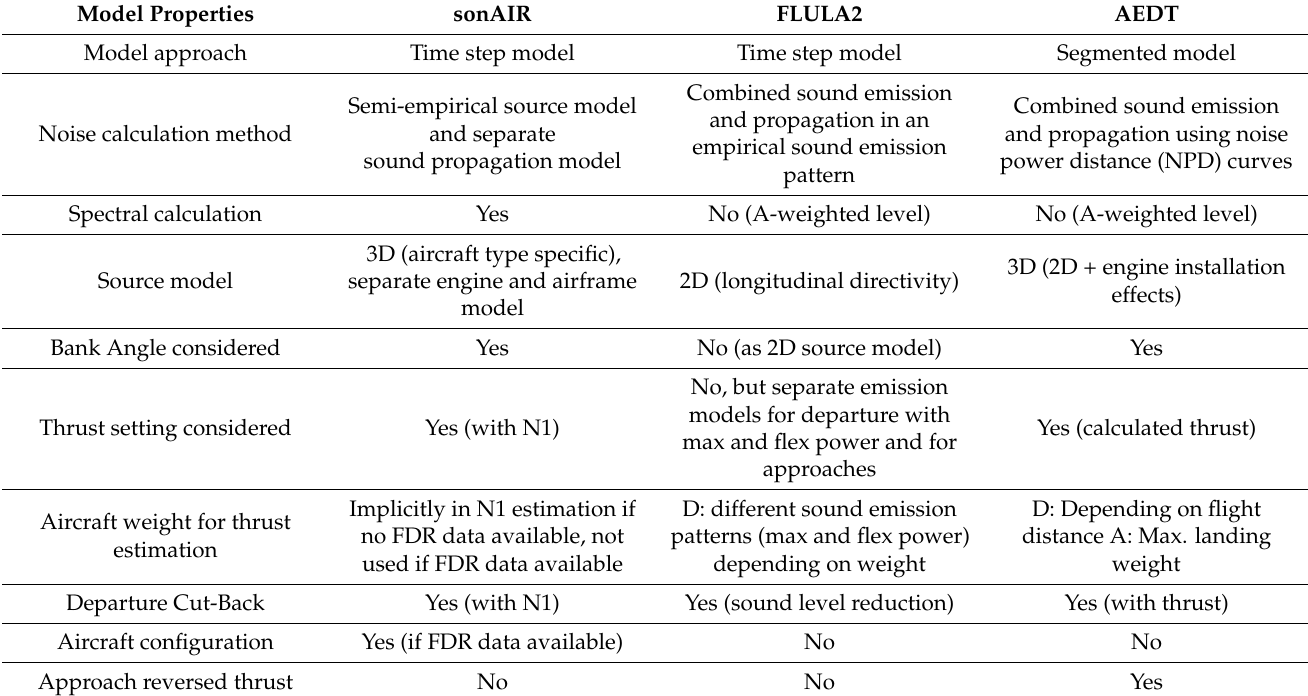
Table 2. Properties of the three programs for the calculations in the scope of this paper. Model